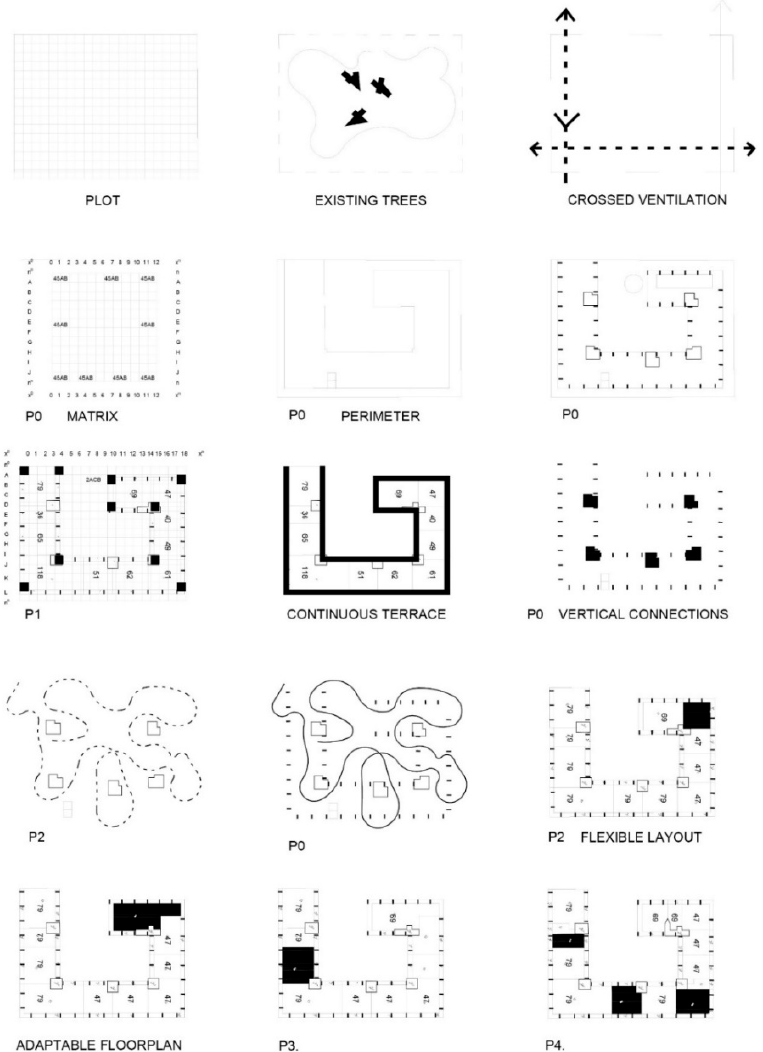
Figure 2. Interior of the dwellings totally free in their personalization and distribution. There are more than 30 different “typologies”. Legend: P0 (Level O), P1, P2, P3 and P4 refer to the different levels or